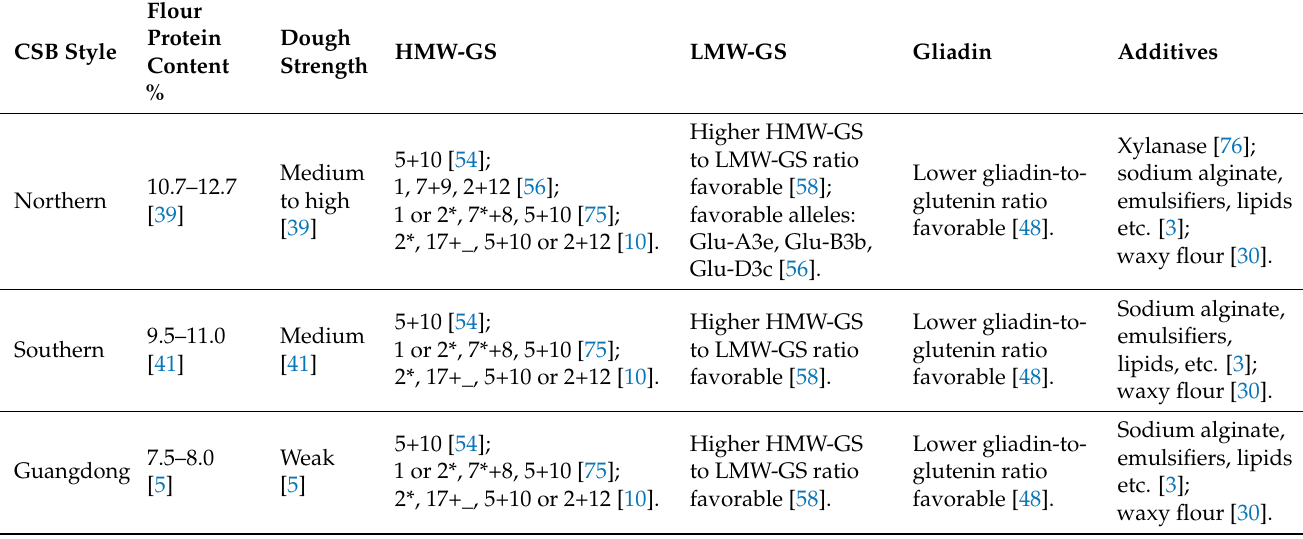
Table 1. Technical parameters and requirements for better CSB